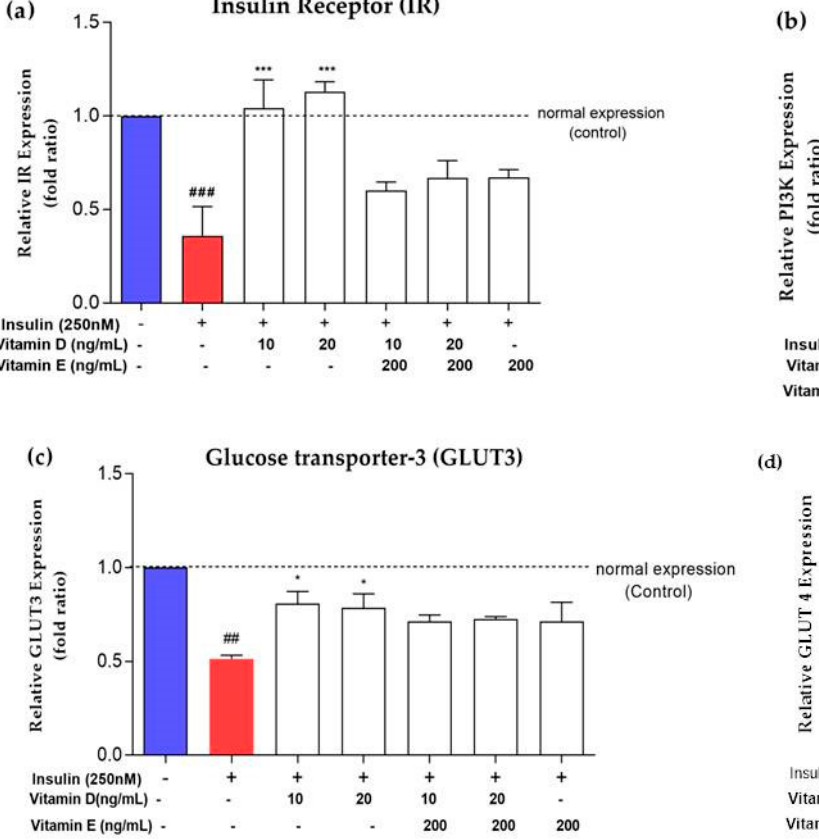
Figure 5. Gene expression levels of ( a ) IR ( b ) PI3K ( c ) GLUT3 and ( d ) GLUT4 after treatment with vitamins D and E at di ff erent concentrations. Red bar represents the expression level upon induction with 250 nM insulin for 16 h. White bar represents the expression level treated with vitamins D and E for 24 h after induced with 250 nM insulin. Relative expression of IR , PI3K , GLUT3, and GLUT4 were normalized with GAPDH . Data were expressed as mean ± SEM of three independent experiments. Significant values were expressed as * p < 0.05, ** p < 0.01, *** p < 0.001 compared to the negative control group and # p < 0.05, ## p < 0.01, ### p < 0.001 compared to the control group.